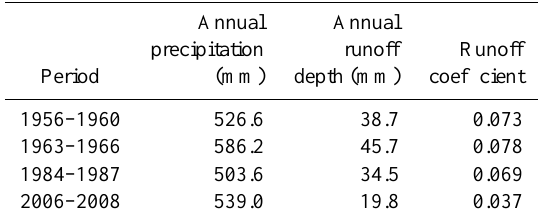
Table 6. Annual precipitation, runoff depth and runoff coefficient in different